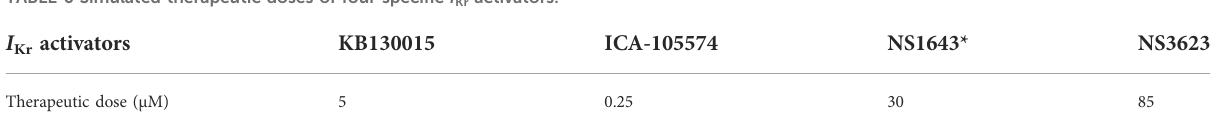
TABLE 6 Simulated therapeutic doses of four speci fi c I Kr activators.